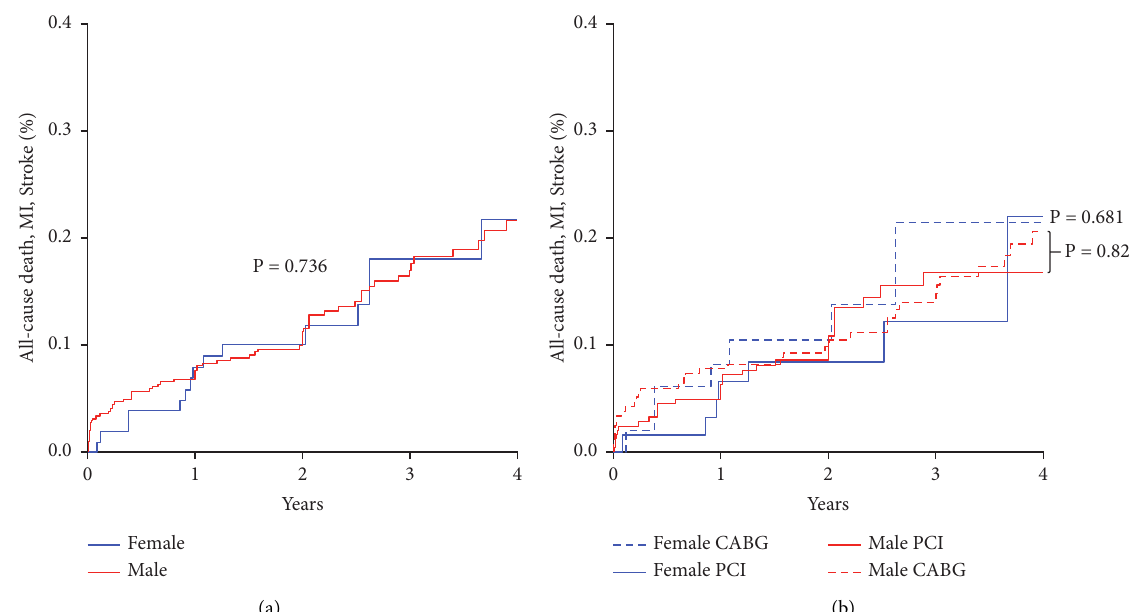
Figure 2: (a) Kaplan–Meier curves for composite primary endpoint according to gender. MI, myocardial infarction; PCI, percutaneous coronary intervention; CABG, coronary artery bypass grafting. (b) Kaplan–Meier curves for composite primary endpoint according to gender and strategy of revascularization. MI, myocardial infarction; PCI, percutaneous coronary intervention; CABG, coronary artery bypass grafting.